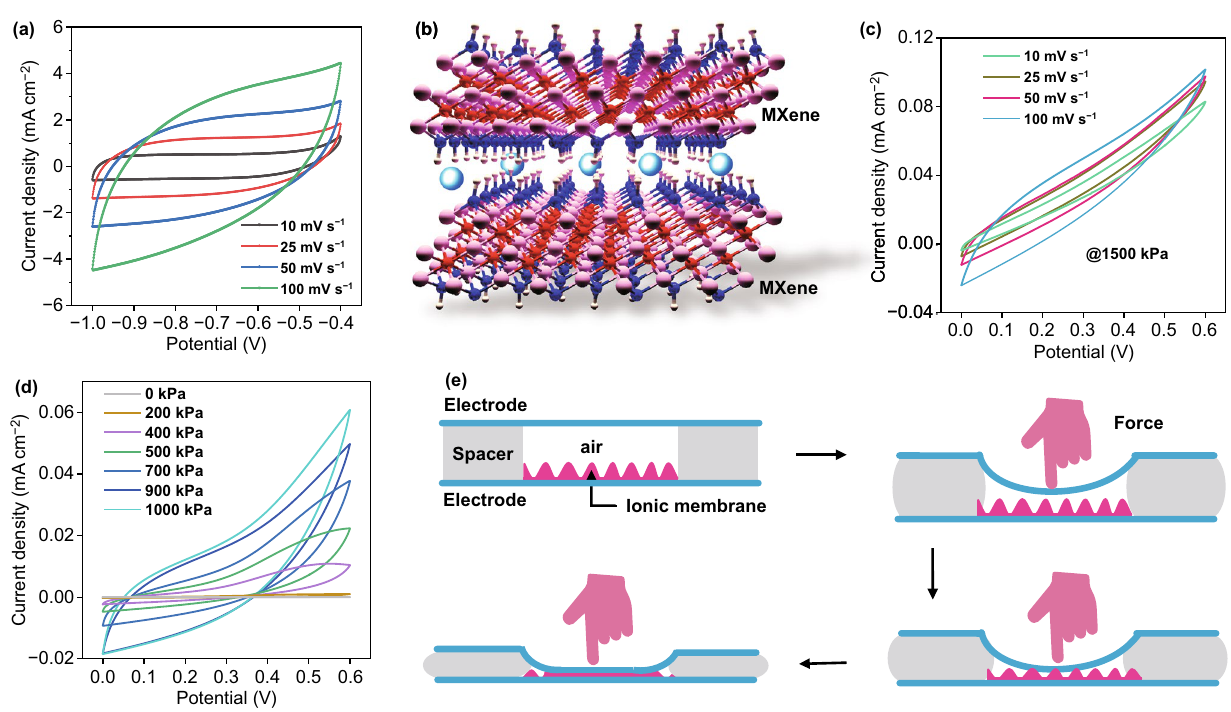
Fig. 4 Mechanism of the iontronic sensor. a CV curves of the MXene tested in three-electrode mode in KOH solution. b Intercalation of K + between Ti 3 C 2 T x layers c CV curves of the symmetrical configuration of the MXene electrode materials tested in two-electrode mode at various scan rates under applied pressure of 1500 kPa. d CV curves of the symmetrical configuration of the MXene electrode materials tested in two- electrode mode at various applied pressures. e Schematic illustration of the working mechanism of the iontronic